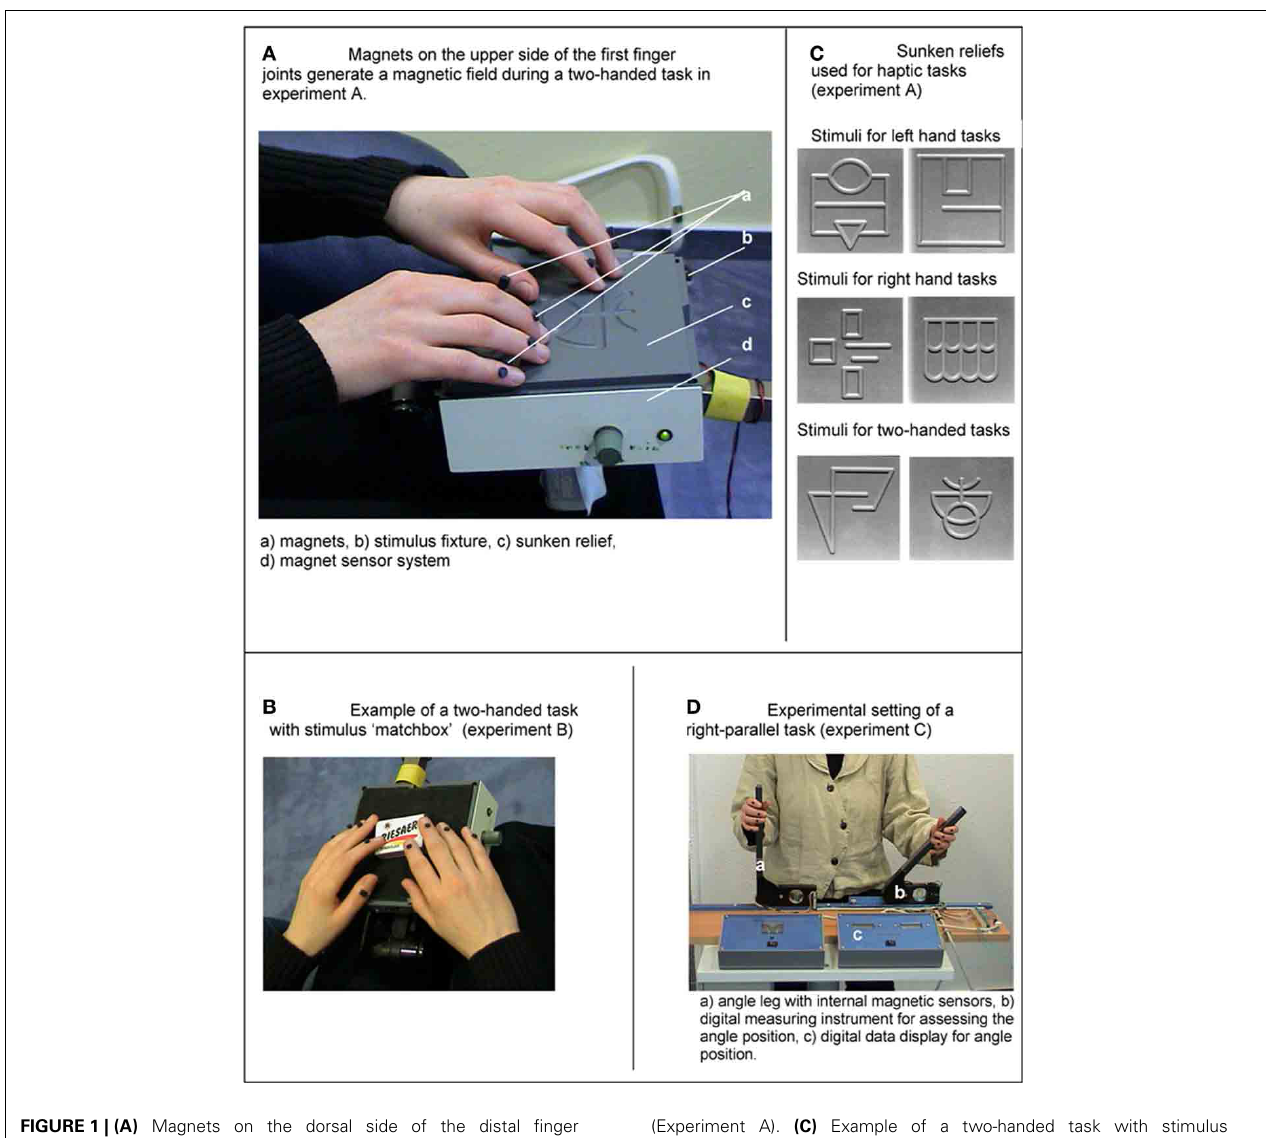
(Experiment A). (C) Example of a two-handed task with stimulus “matchbox” (Experiment B). (D) Experimental setting of a right-parallel task (Experiment